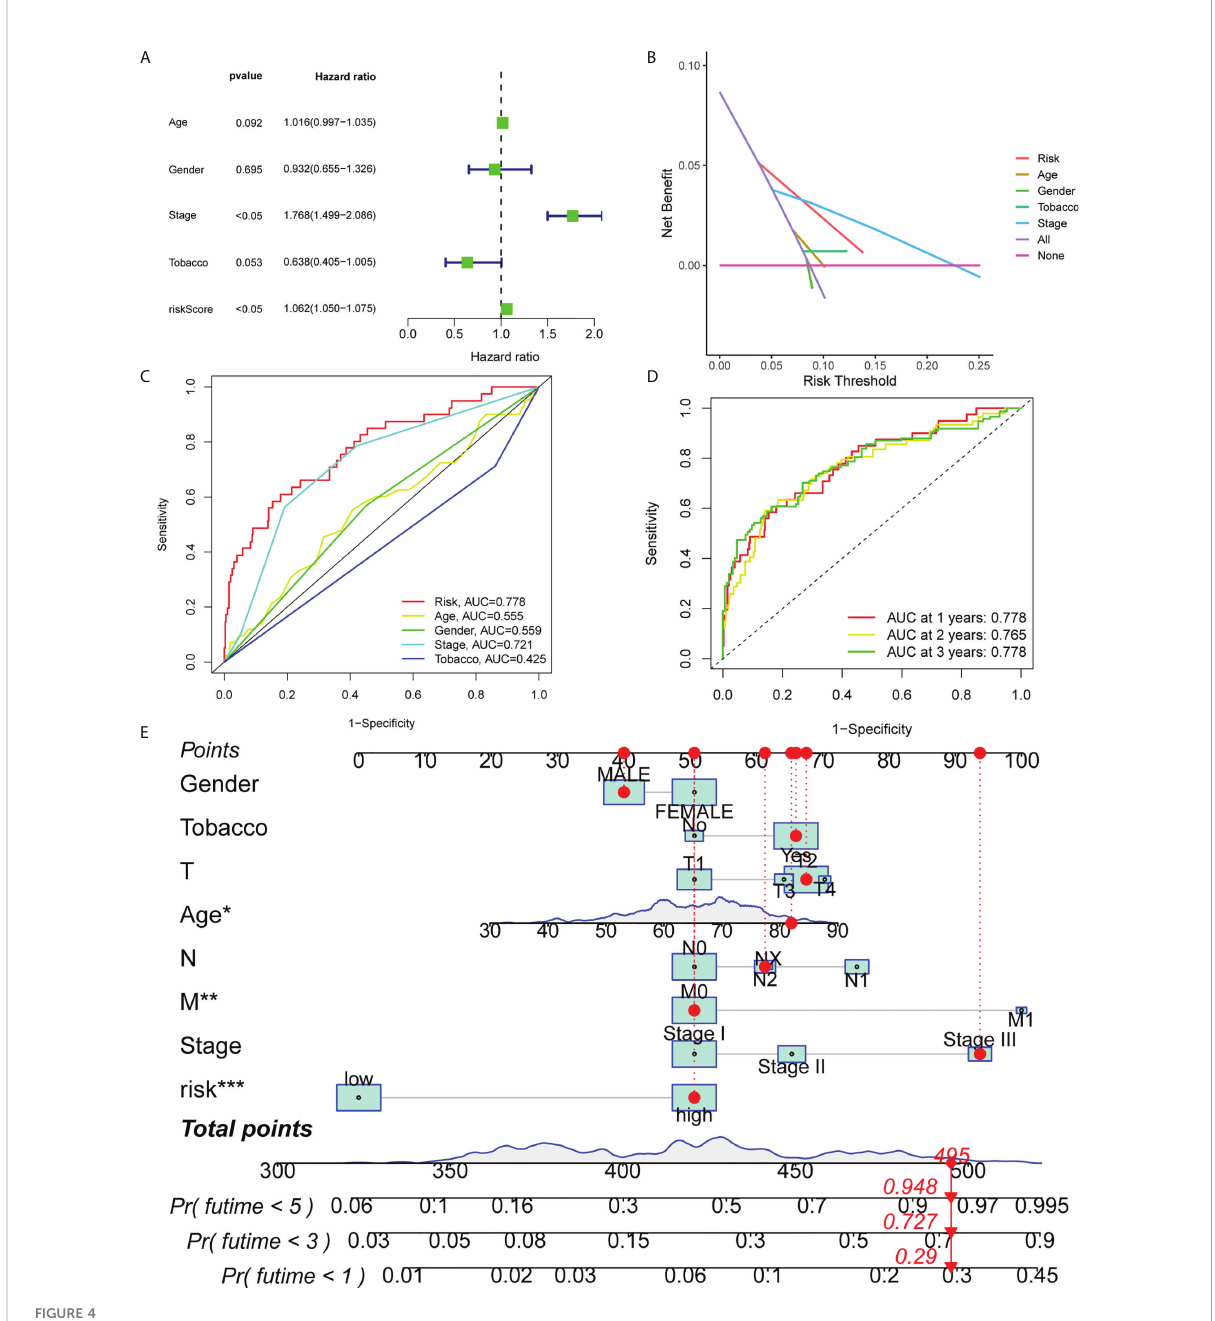
FIGURE 4 Independent prognostic factors for OS in LUAD. (A) Multivariate Cox regression analysis is shown. (B) Decision curve analysis is presented. (C) ROC curves of risk scores and other clinical characteristics based on OS are shown. (D) ROC curves predicting the OS of patients with LUAD at 1, 3 and 5 years are shown. (E) Nomogram validating the OS of patients with LUAD. OS, overall survival; ROC, receiver operating characteristic; LUAD, lung adenocarcinoma. *means p<0.05, **means p<0.01, ***means